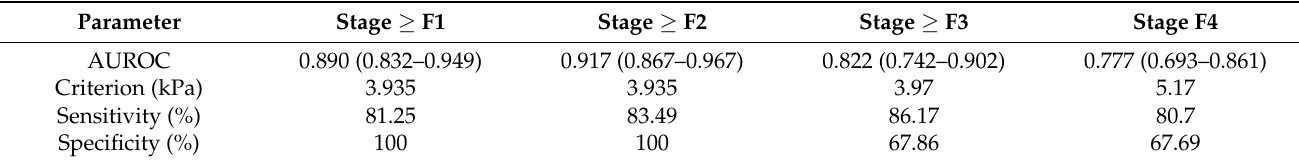
Table 3. Diagnostic performance of